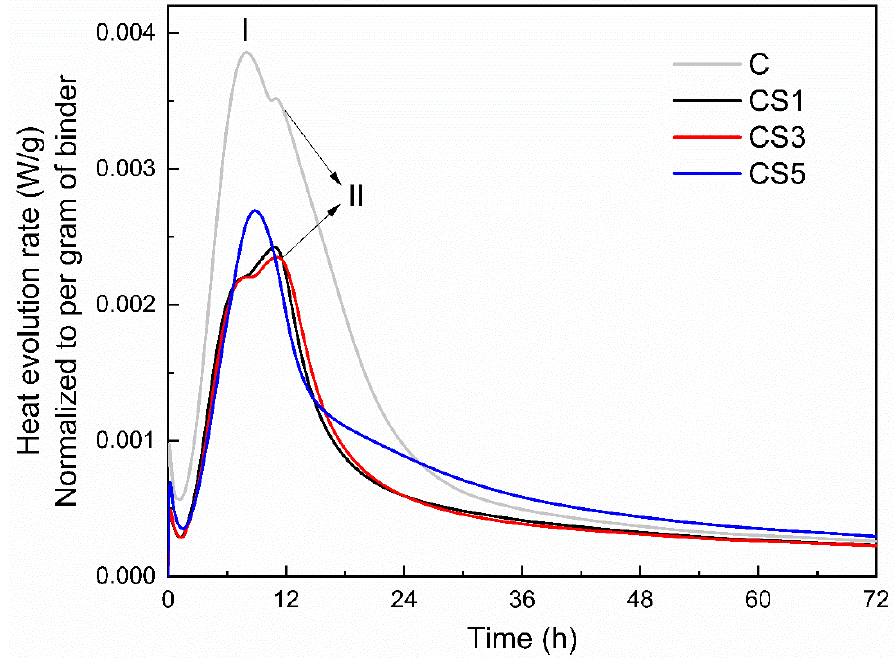
Figure 7. Heat evolution rate of slag blended pastes during 72 h of hydration.